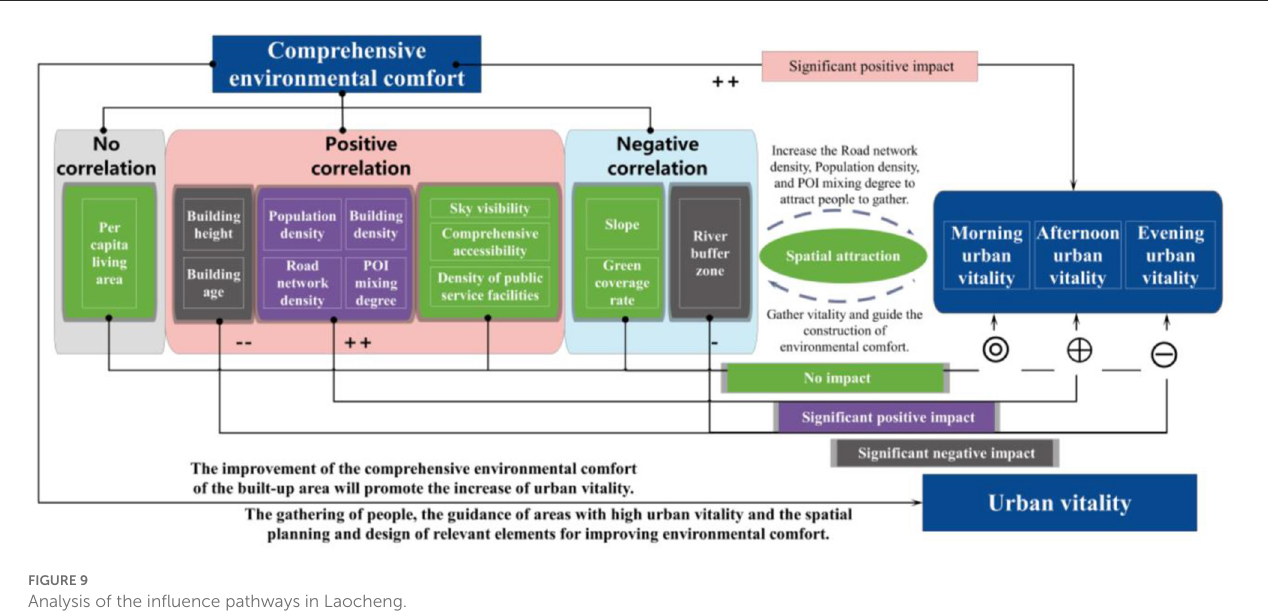
FIGURE9 Analysis of the influence pathways in